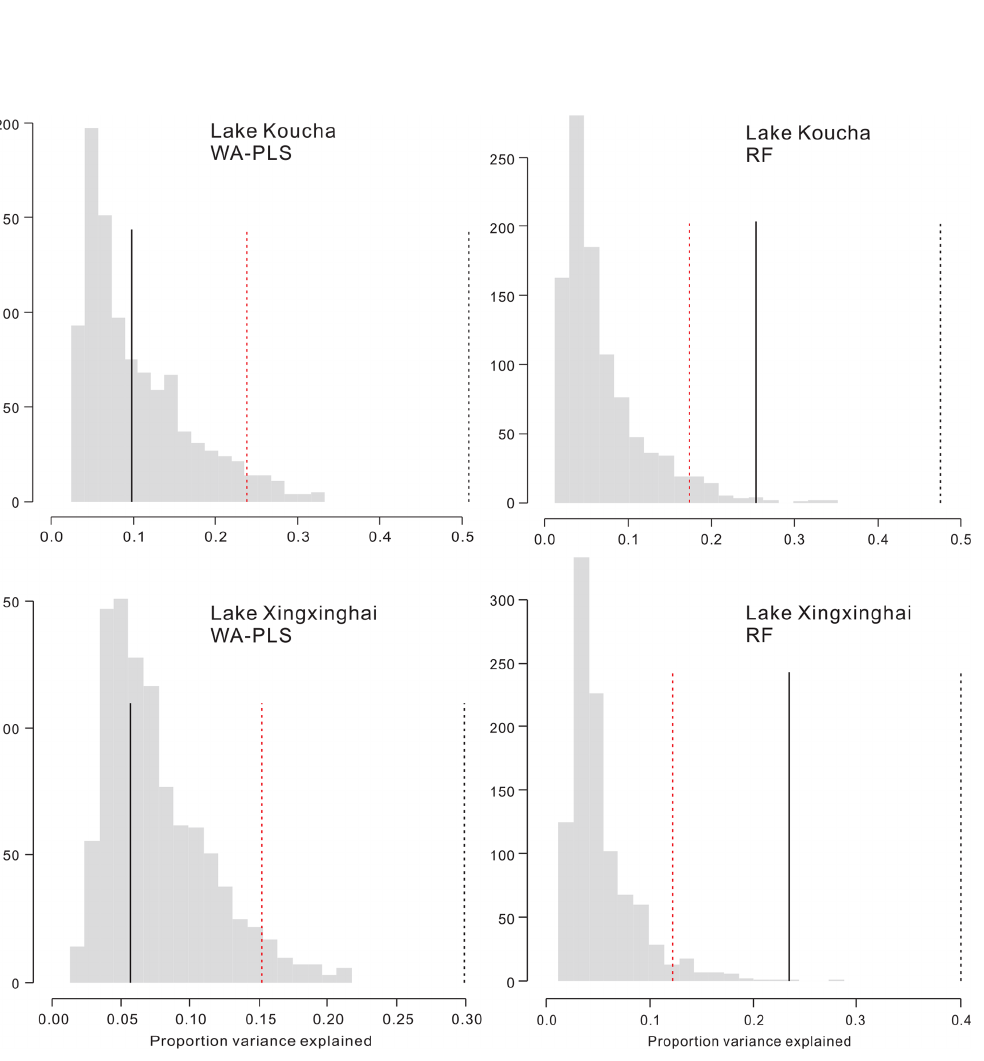
Figure 6. Statistical significance test of P ann reconstructions from two lakes using weighted-averaging partial least squares regression (WA- PLS) and the random forest (RF) algorithm. Grey histograms indicate the proportion of variance in the fossil pollen spectra explained by random variables (999 times), and the dotted red line is the 95% quantile, the dotted black line is the variance in the pollen explained by the first PCA axis, and the solid black line is the explanation by the reconstructed P ann